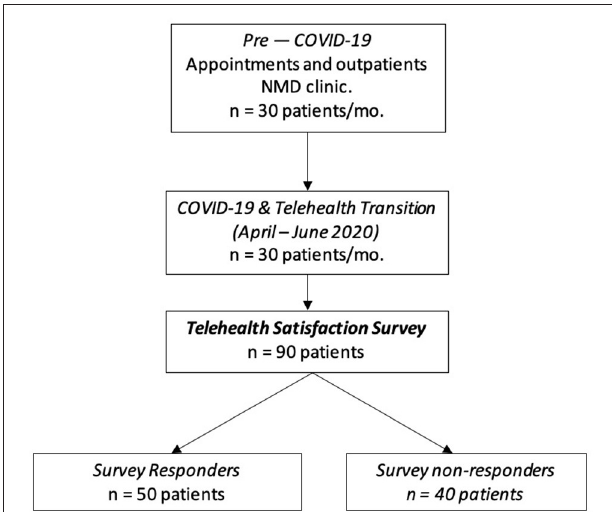
FIGURE 1 | Schematic representation of patient selection. Data assessing patient satisfaction with video visits during the COVID-19 pandemic was collected between April and June 2020. All patients had an existing diagnosis of a neuromuscular disease (NMD) and were seen for return visits. A survey assessing the visits was sent to 90 patients. In that 90-person cohort, 50 were responders and 40 non-responders. Further analysis was done on the 50